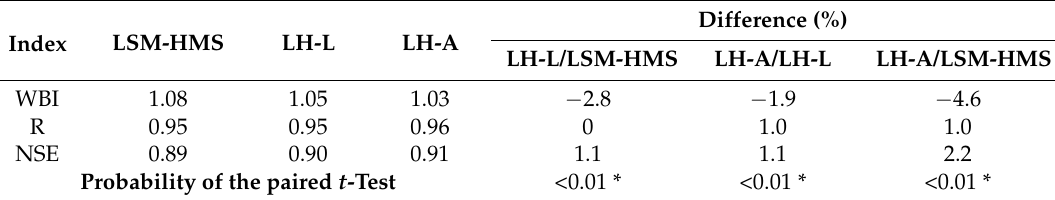
Table 3. Comparison of monthly streamflow